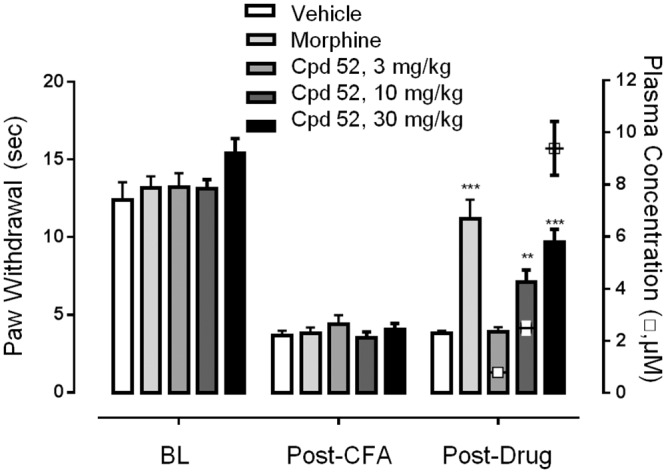
Compound 52 produced dose-dependent efficacy against thermal hyperalgesia in the CFA model.Paw withdrawal latency (bars and left y-axis) and terminal plasma concentration of compound 52 (hollow square symbols and right y-axis) for each cohort of animals is shown at baseline (BL), 24 hours following CFA injection (Post-CFA), and 24 hours following CFA injection after administration of either vehicle, morphine, or the indicated dose of compound 52 (Post-Drug). Data are mean ± SEM, n = 7–10 animals per cohort. Average reversal for each condition compared to baseline: morphine 87%, 10 mg/kg compound 52 40%, and 30 mg/kg compound 52 53%. Terminal plasma and brain concentrations of compound 52: for the 3 mg/kg dose plasma 0.78 μM ± 0.042 μM (n = 8) (brains not analyzed); for the 10 mg/kg dose plasma 2.48 μM ± 0.22 μM (n = 7) and brain 0.81 μM ± 0.063 μM (n = 3); for the 30 mg/kg dose plasma 9.39 μM ± 1.03 μM (n = 7) and brain 2.36 μM ± 0.38 μM (n = 3) (all values mean ± SEM). **p < 0.01, ***p < 0.001.